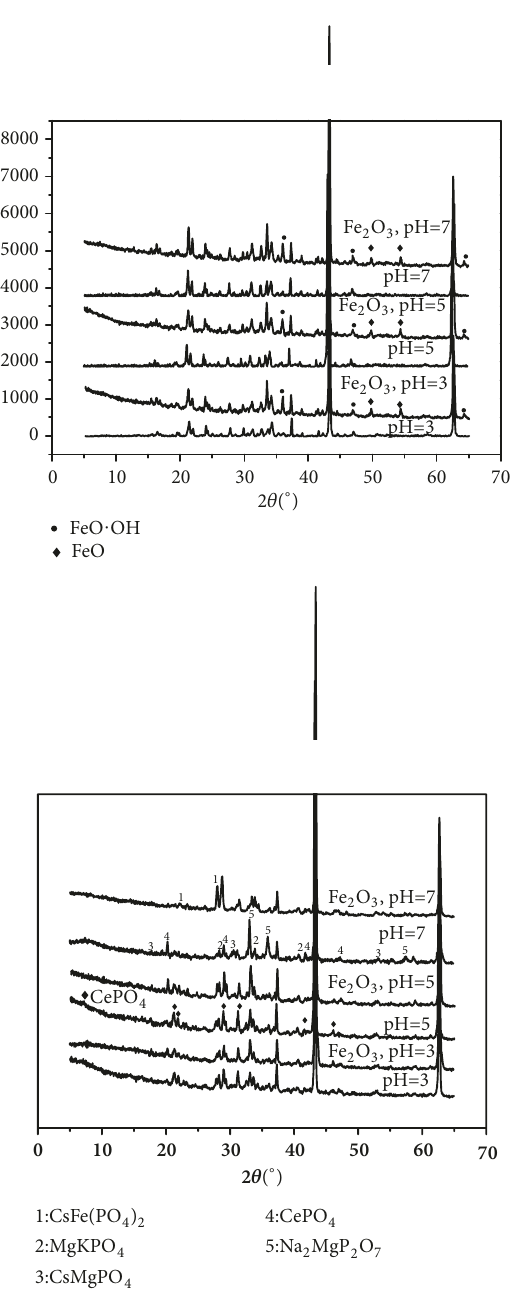
Figure 5: XRD spectrum of solidification forms ( A unsintered, B sintered at 900 ∘ C).